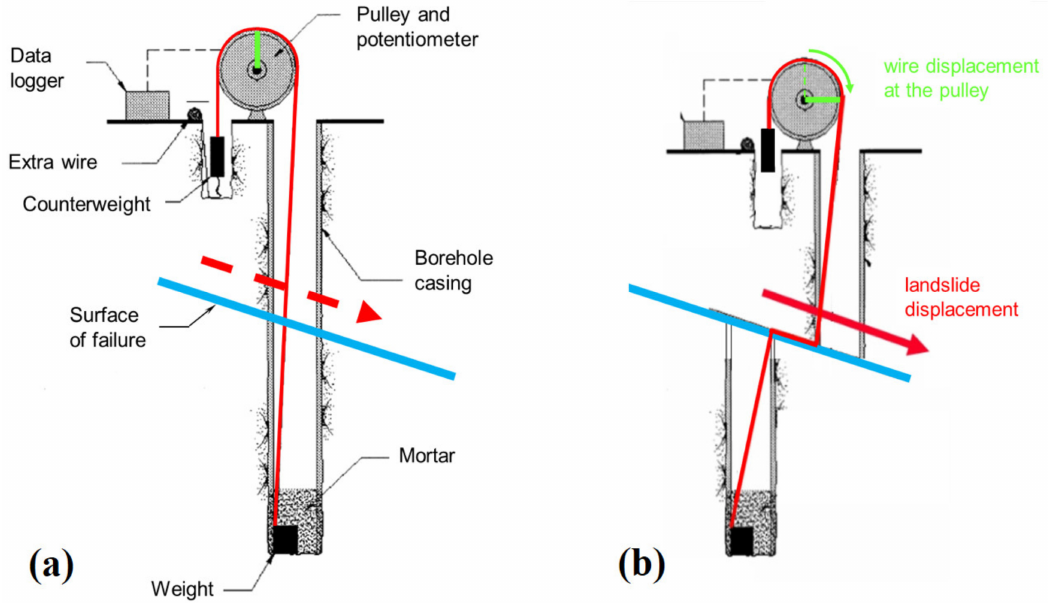
Figure 13. Sketch of the borehole wire extensometer. ( a ) just after installation; ( b ) after some shear displacement of the landslide (idealized). The relationship between the wire displacement at the pulley and the horizontal displacement of the landslide depends on the width of the shear zone and the borehole diameter [4]. The smaller the borehole diameter, the faster the wire